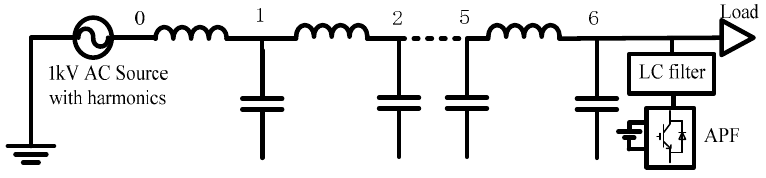
Figure 5. Simulation system.